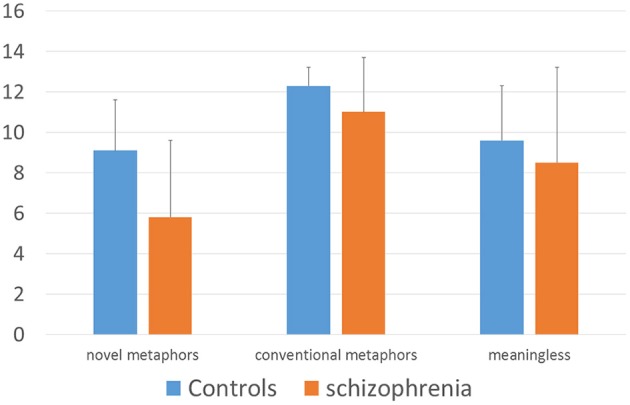
Performance of patients with schizophrenia (n = 23) and healthy control subjects (n = 19) in a new developed German multiple choice metaphor comprehension test. Mean performance and standard deviations. A value of 13 would indicate perect performance.